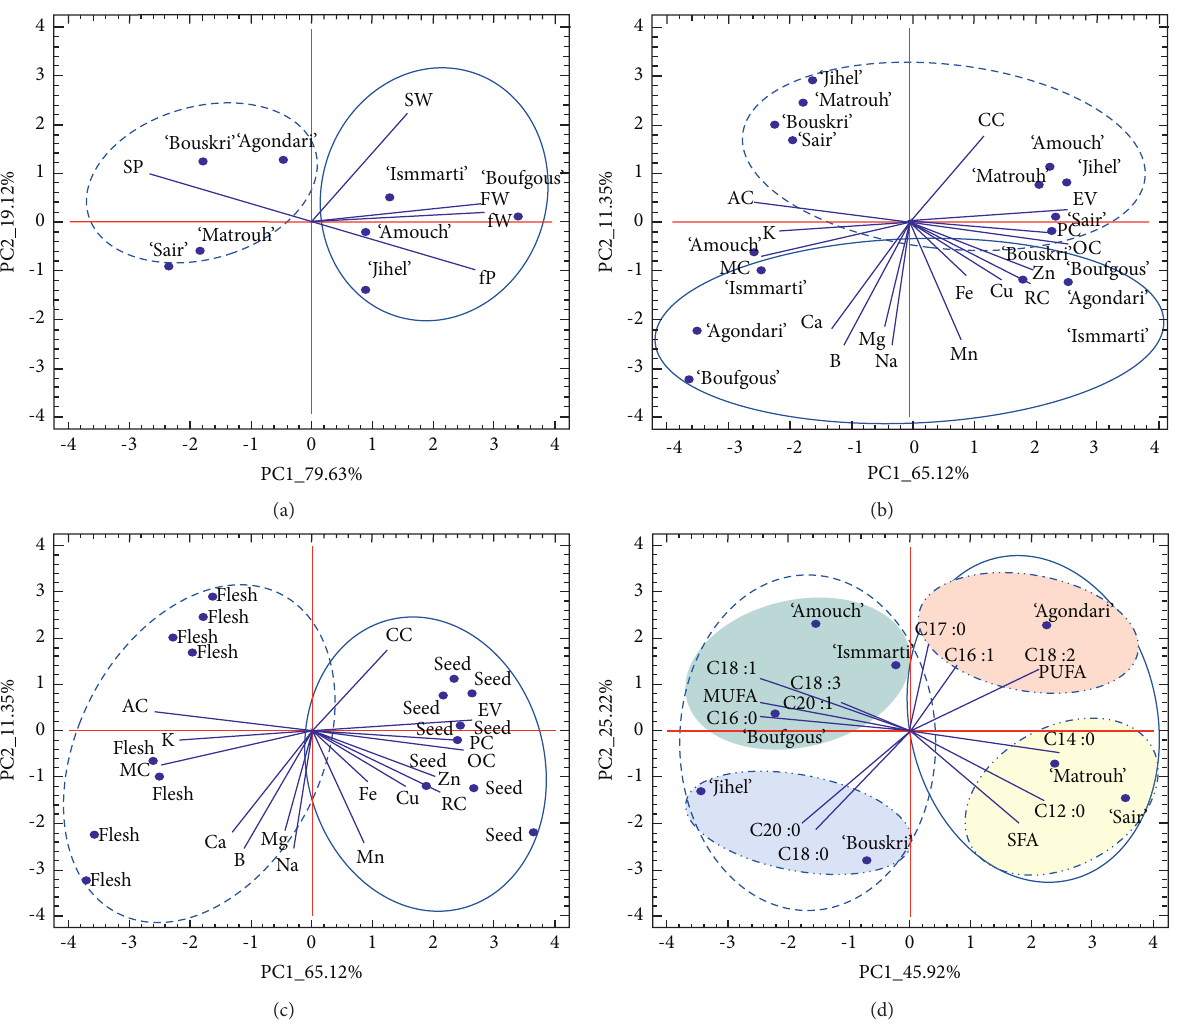
Figure 1: Principal component analysis (PCA) projections on PC1 and PC2. Eigenvalues are symbolized as blue segments representing parameters that most affect each principal component. Plotted points are mean values of each studied parameter of various date palm varieties. FW: fruit weight, fW: flesh weight, SW: seed weight, fP: flesh percentage, SP: seed percentage, AC: Ash content, CC: carbohydrates content, PC: protein content, EV: energy value, OC: oil content, MC: moisture content, RC: reducing capacity. C12: 0: lauric acid, C14:0: myristic acid, C16: 0: palmitic acid, C16:1: palmitoleic acid, C17: 0: margaric acid, C18: 0: stearic acid, C18:1: oleic acid, C18:2: linoleic acid, C18: 3: linolenic acid, C20 :0: arachidic acid, C20 :1: gadoleic acid, SFA: saturated fatty acids, MUFA: monounsaturated fatty acids, and PUFA: polyunsaturated fatty